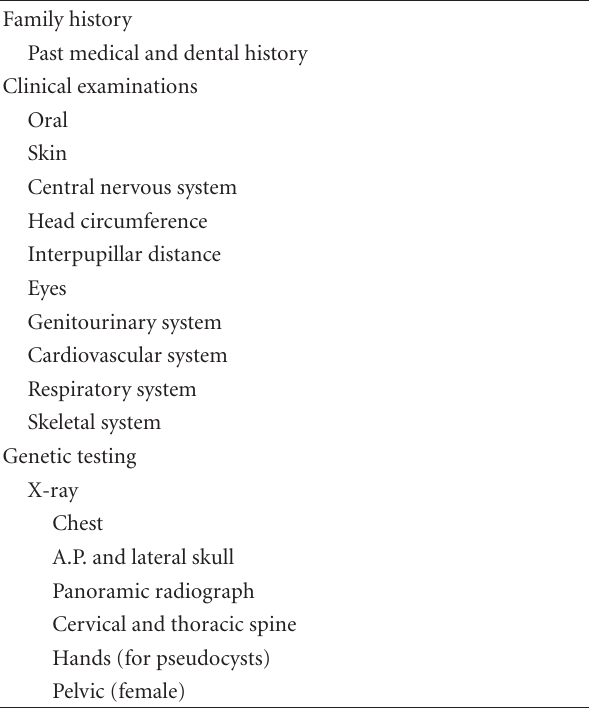
Table 1: Diagnostic protocols in